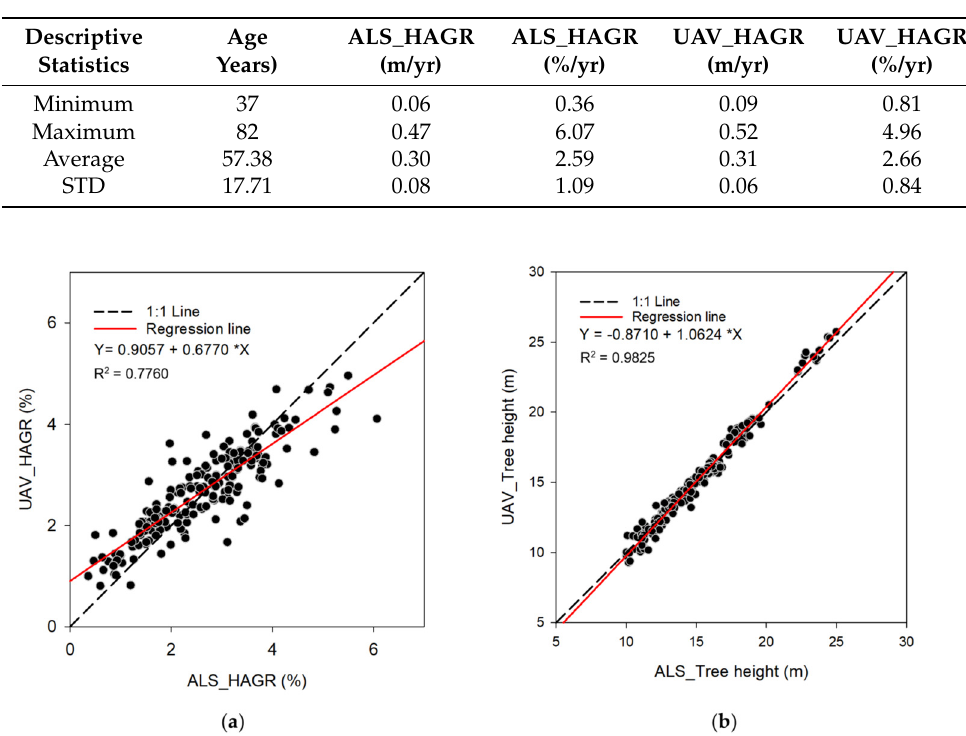
Figure 12. Dependency of the height annual growth rate estimates ( a ) and tree height ( b ) between the ALS and UAV approaches.